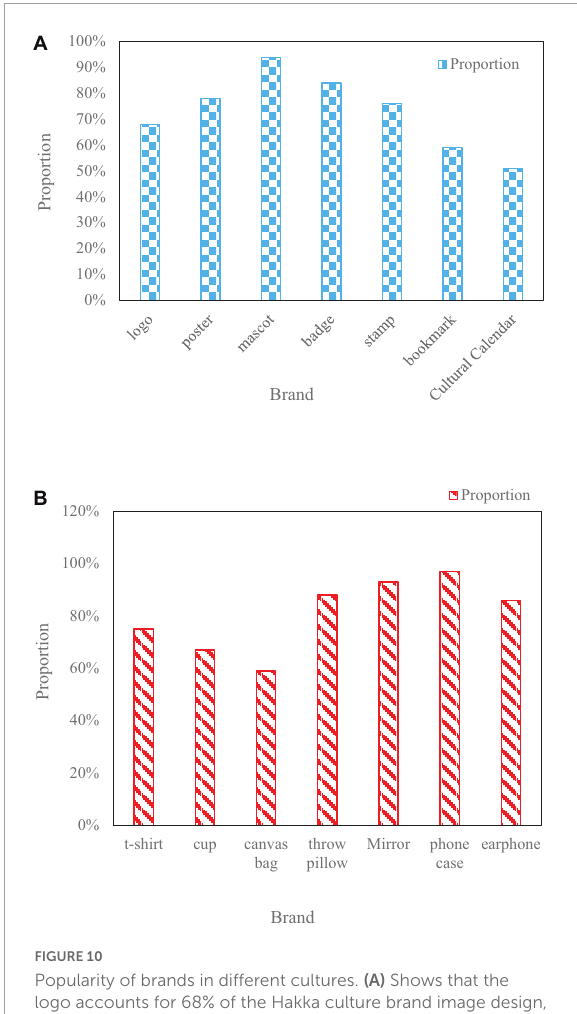
FIGURE10 Popularity of brands in different cultures. (A) Shows that the logo accounts for 68% of the Hakka culture brand image design, 78% for the poster, and 94% for the mascot. (B) Shows that the mobile phone case is the most popular in this Hakka culture brand image design, and the popularity is as high as 97%. At the same time, the popularity of different products is above 50%, which also indirectly shows that the design of this design